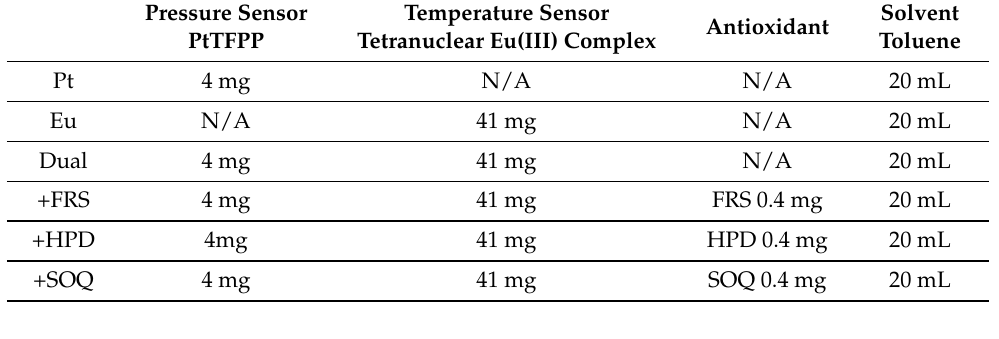
Table 2. Dye solutions.